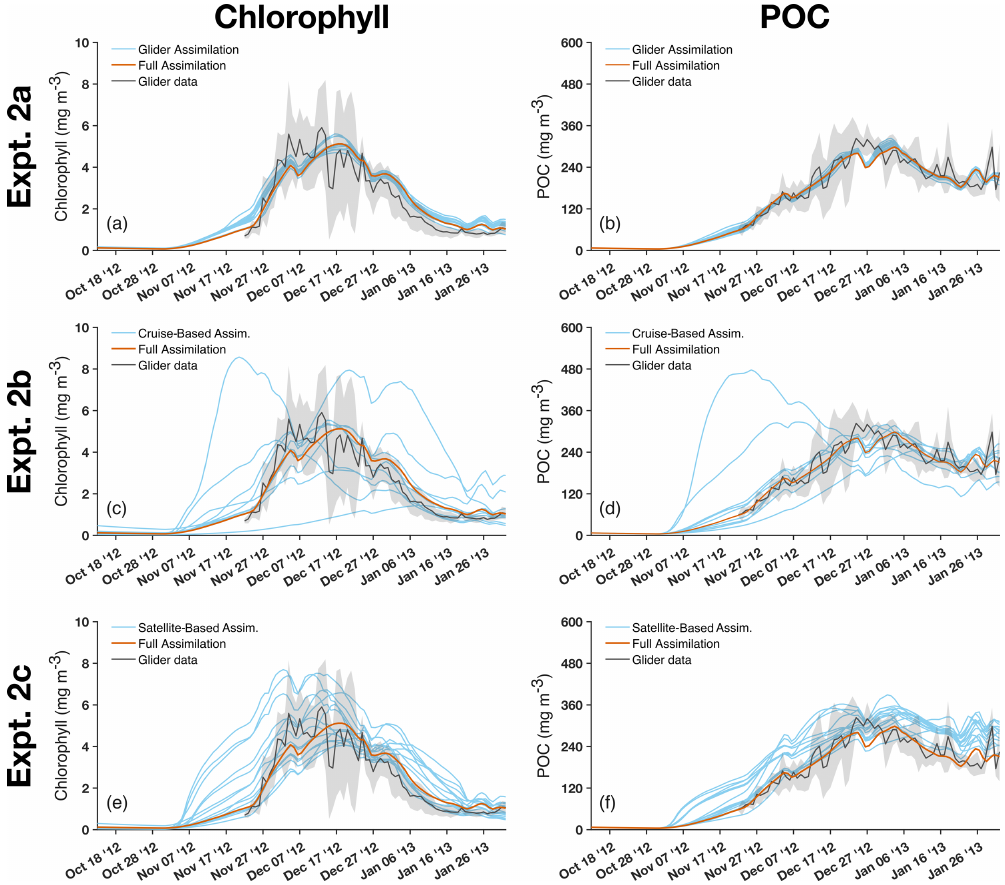
Figure 8. Upper 50m mean concentrations of (a, c, e) Chl and (b, d, f) POC for various experiments assimilating subsets characteristic of the original glider data, cruise-based observations and satellite-based observations (Table 2): (a, b) Experiment 2a – glider observations; (c, d) Experiment 2b – cruise-based observations; and (e, f) Experiment 2c – satellite-based observations. For reference, model results for the Full Assimilation case (orange lines) and glider data (black lines) with shading (gray) representing 1 SD (from the upper 50m) are included in each